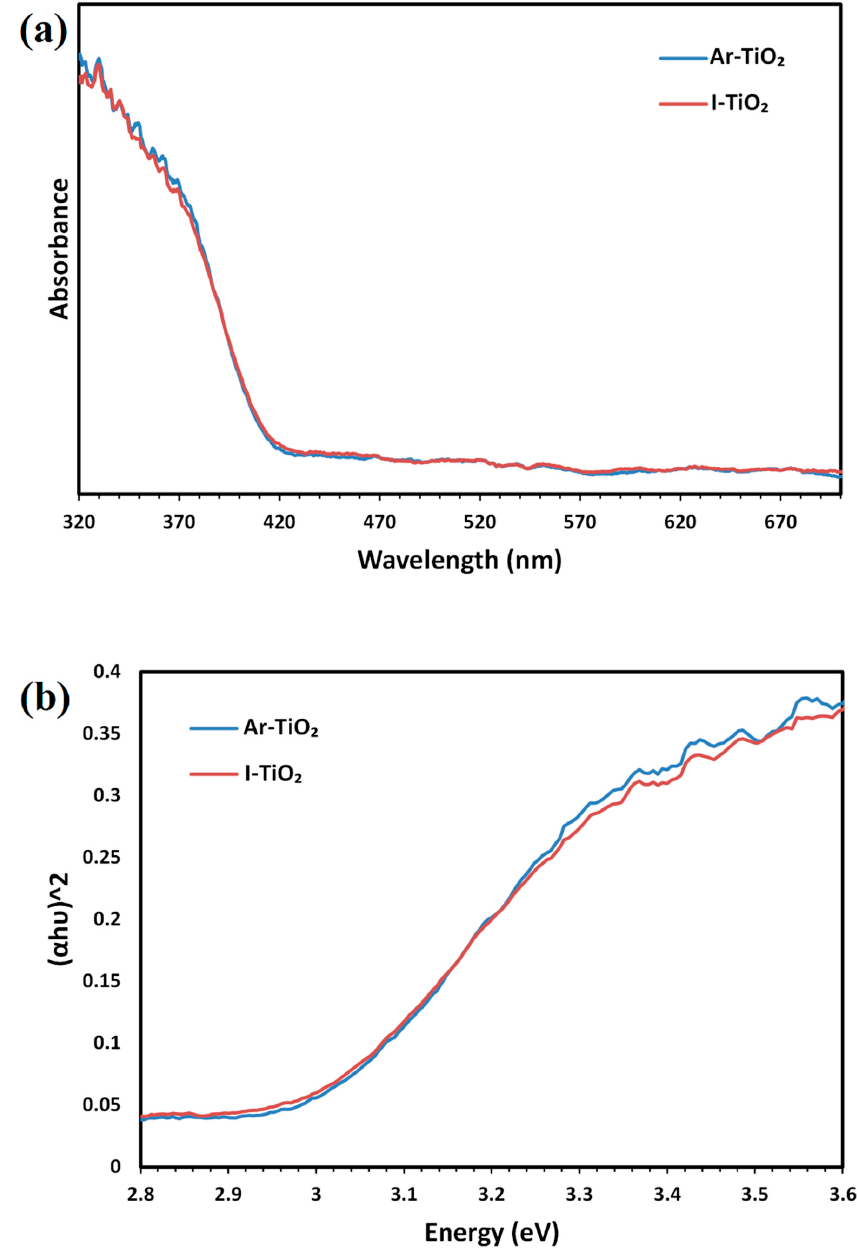
Figure 3. UV-vis DRS of: ( a ) Ar-TiO 2 and I-TiO 2 samples and ( b ) plot of ( α hv) 2 as a function of hv for determining the band gap.